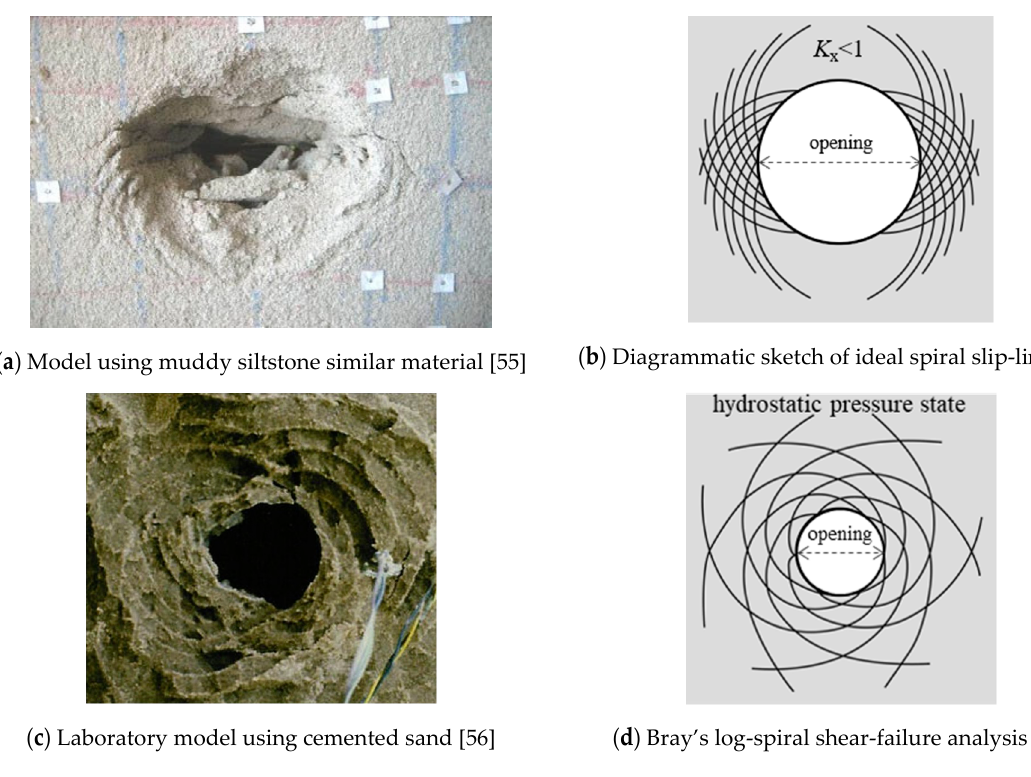
Figure 12. Some footnote about log-spiral shear-failure slip lines.